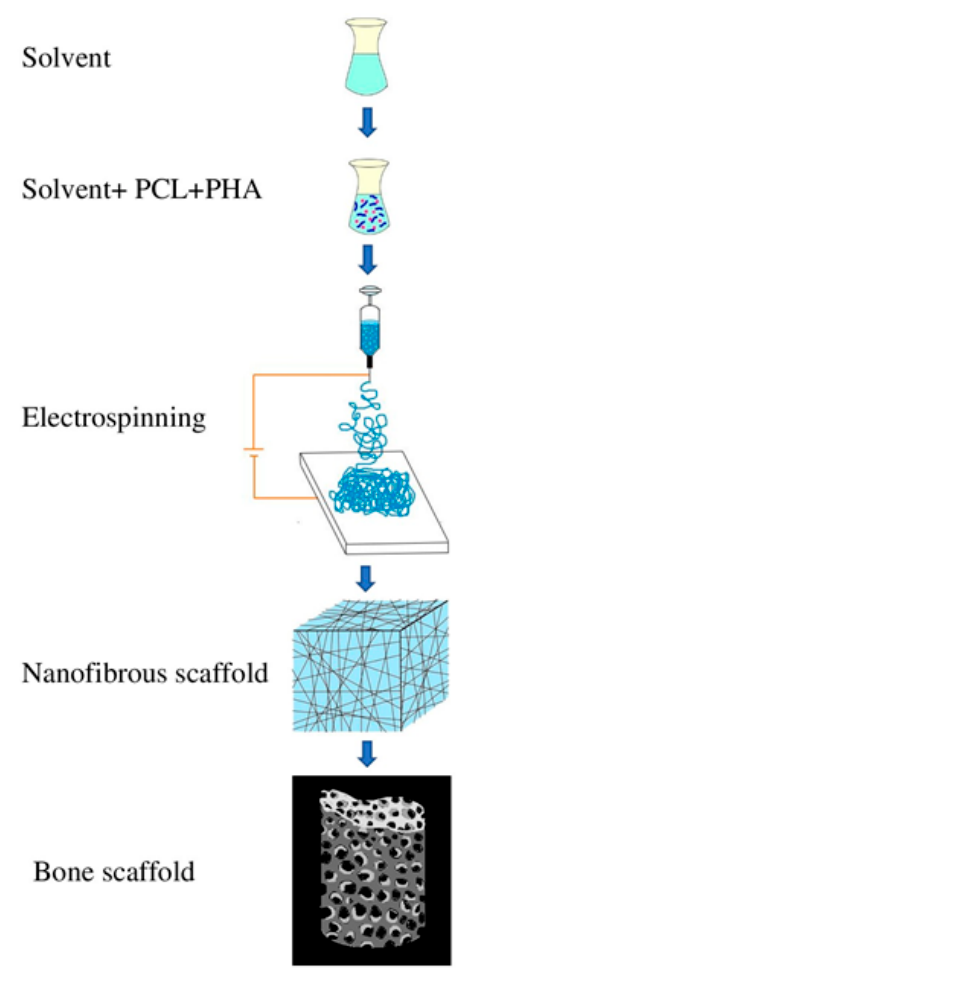
Figure 10. Electrospinning approach for fabricating a bone scaffold using PHA nanocomposite.